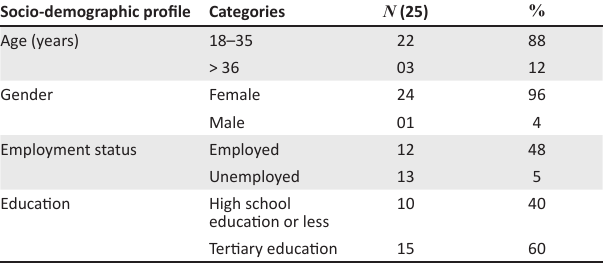
TABLE 3: Demographic profile of caregivers of children aged from 6 to 24 month. Socio-demographic profile Categories